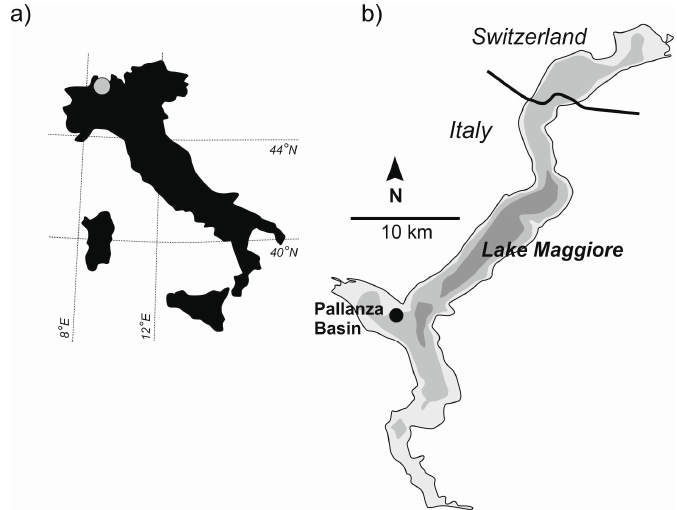
Figure 1. ( a ) Location of Lake Maggiore in northern Italy (gray dot) and ( b ) location of the sediment core sampling site in the Pallanza Basin of Lake Maggiore (black dot), where the shades of gray represent bathymetric details (light gray < 100 m, mid gray 100–300 m, and dark gray > 300 m water